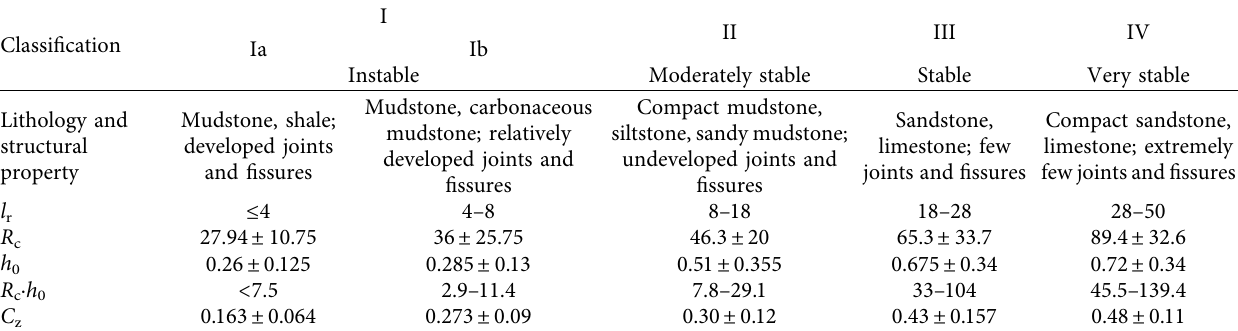
Table 2: Classification system for immediate roof